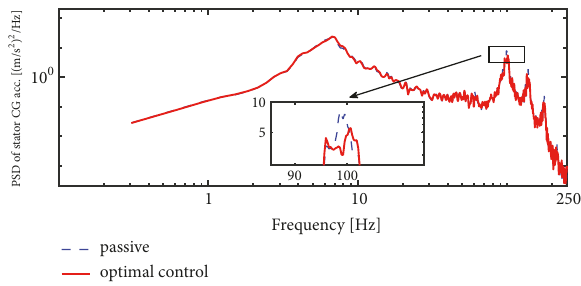
Figure 7: Frequency response of stator acceleration.